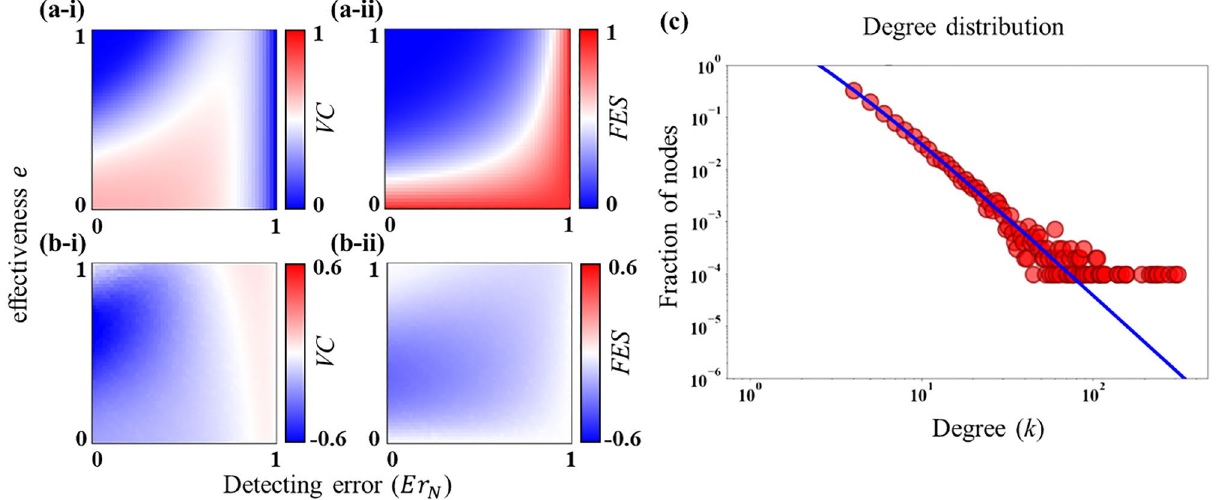
Figure 7. Results obtained from the analytic method. Outcomes are generated from the analytic approximation (illustrated in Eqs. (2)–(6)) as a function of detecting error (error in detecting susceptible neighbors, Er N ) and vaccine efficacy e (panels ( a-* )). Panel ( b-* ) demonstrates the difference in outcomes by subtracting results obtained in MAS (i.e., the corresponding panels (a-ii) and (b-ii) in Fig. 3) from that of the analytic approximation. The gap between the analytical prediction and stochastic simulation arises from the deviation in degree distribution (for BA scale-free network with < k > = 8 ) between theory and MAS. Note that the 2 m ( m + 1 ) , where m is the half of the average analytic approximation assumes the degree distribution as P ( k ) = k ( k + 1 )( k + 2 ) degree 48 . Furthermore, we adjust the transmission rate β for the analytic method as β = 0.148 (see Appendix D in SI for more details). Other relevant parameters are stated in Table